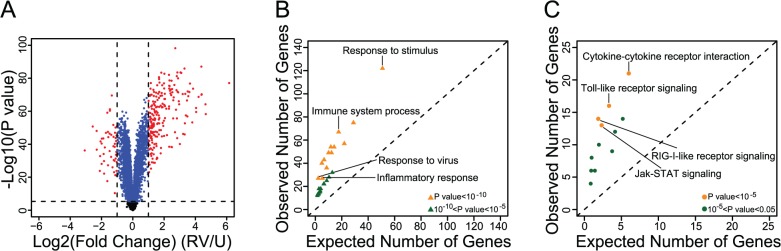
Identification and functional characterization of RV-responsive genes in PBMCs.
(A) Volcano plot showing the Log2 Fold change (x-axis) and the—Log10 P value (y-axis) of gene expression between uninfected and RV-infected PBMCs. Genes that were not classified as differentially expressed are shown in black. Genes that were significantly differentially expressed (P<4.6x10-6) but displayed <2-fold change are shown in blue; genes that were both significantly differentially expressed and had ≥2-fold change are shown in red. (B) Gene ontology (GO) enrichment results of the genes that were both significantly differentially expressed and had ≥2-fold change (see S3 Table for results including all GO terms). (C) Kyoto Encyclopedia of Genes and Genomes (KEGG) pathway enrichment results of the genes that were both significantly differentially expressed and had ≥2-fold change (see S4 Table for results including all KEGG terms).